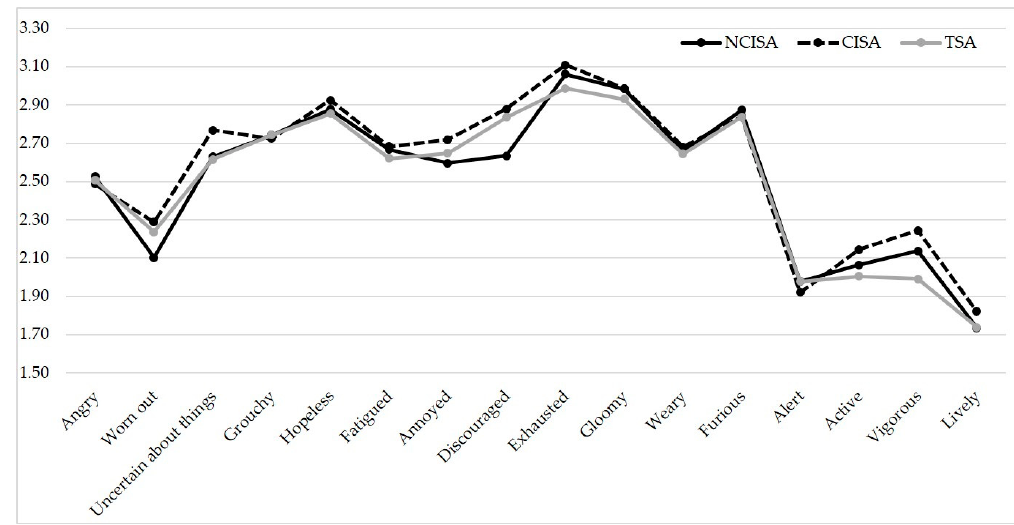
Figure 1. Mood states of different groups of athletes during the COVID-19 pandemic.